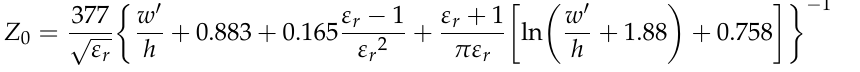
Table 1. Dimensions of the proposed glass antenna.